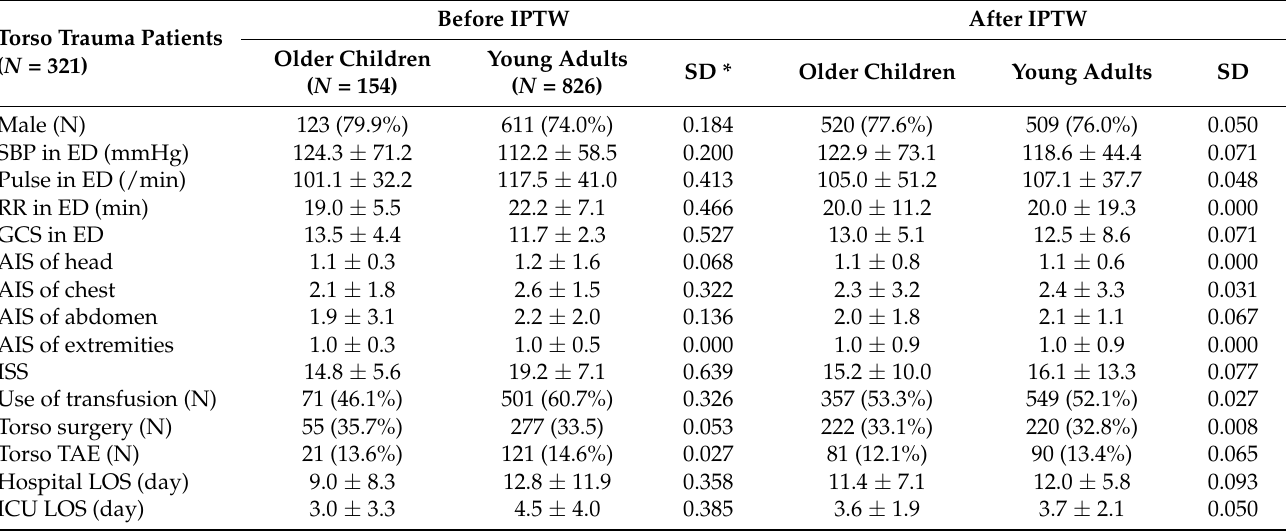
Table 3. Comparisons of demographics, vital signs, injury severities, treatment policies and outcomes between older children and young adults before and after IPTW ( N =